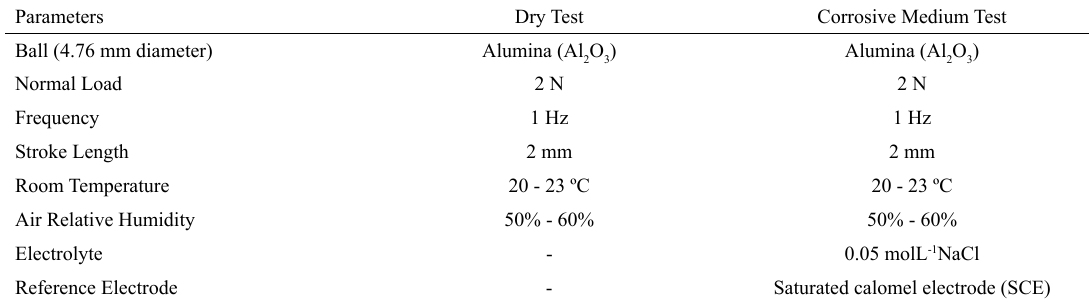
Table 4. Parameters used for wear tests.